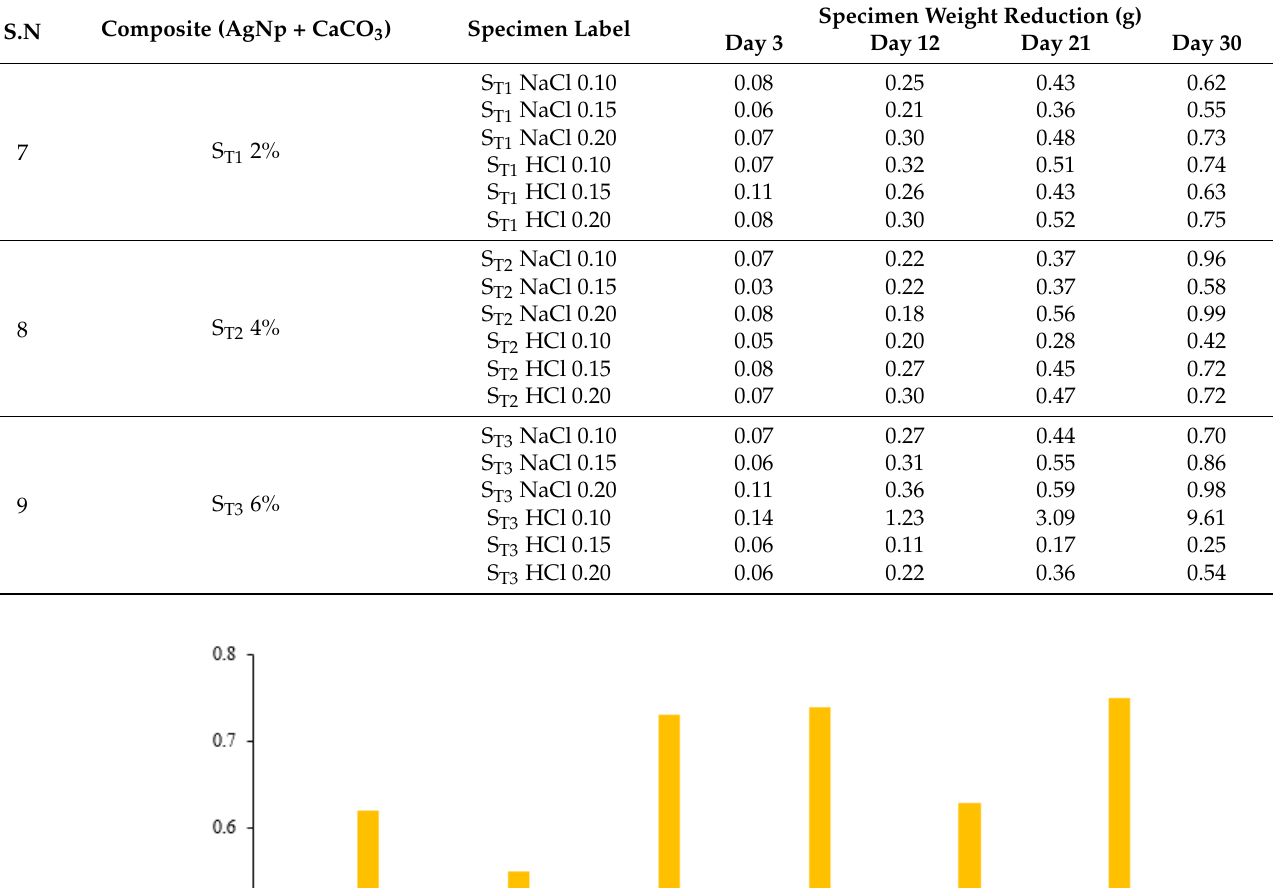
Table 9. Specimen S T1 , S T2 and S T3 weight reduction in HCl and NaCl.